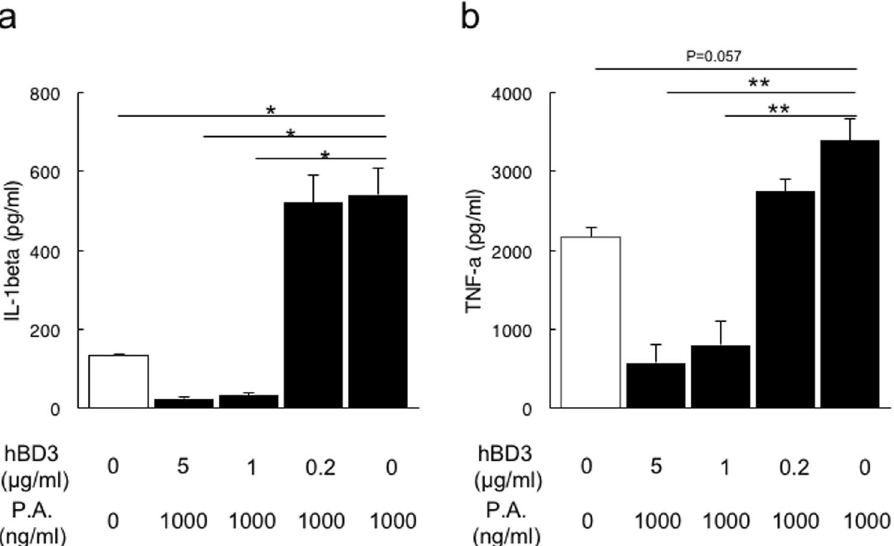
Figure 5. Suppression of P . gingivalis antigen-induced inflammatory cytokine release in THP-1 by hBD3. PMA-primed THP-1 cells were pretreated with various doses of hBD3 for 30 min and stimulated with 1,000 ng/ mL of P . gingivalis antigen for 23 h. The culture supernatants were collected and subjected to IL-1 β - and TNF- α - specific ELISAs. The data are presented as the means SD (n = 3) of three independent experiments; ** p < 0.01, * p <